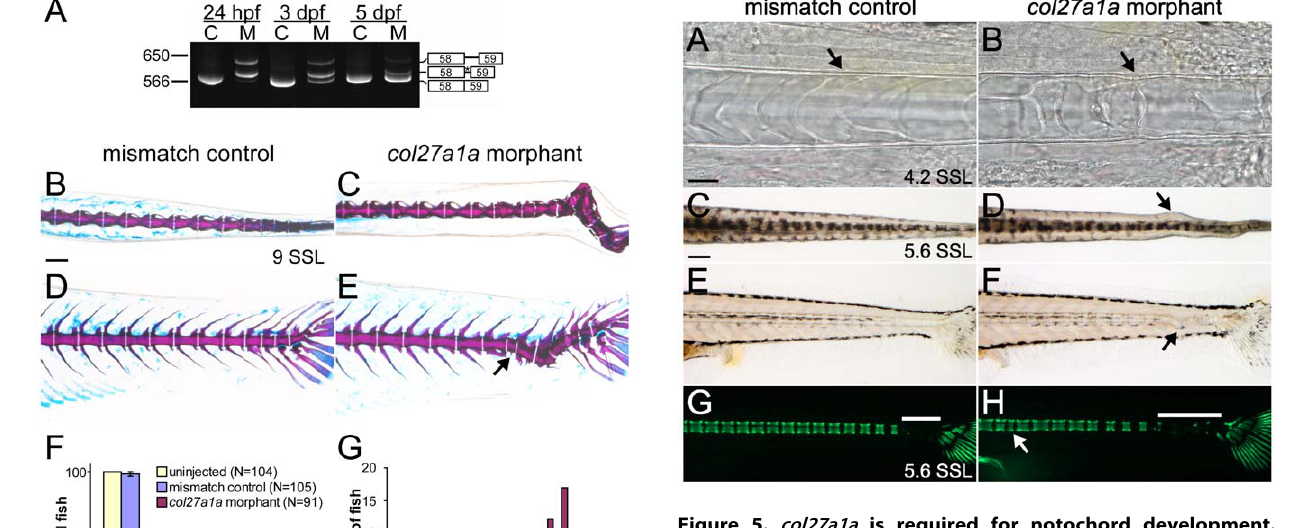
Figure 5. col27a1a is required for notochord development. Brightfield analysis of morphant (B) and mismatch control (A) notochords at , 4.2 SSL (8 dpf) showed buckling of the notochord sheath. Dorsal (D) and lateral (F) views of col27a1a morphants at , 5.6 SSL (14 dpf) show formation of notochord curves at the distal end of the tail. (C, E, G) Mismatch control siblings. (H) Calcein staining to visualize mineral showed abnormal vertebrae (white arrow) and decreased mineralization (white bar indicates unmineralized region). Scale bar in A represents 20 m m and applies to B. Scale bar in C represents 200 m m and applies to D–H.